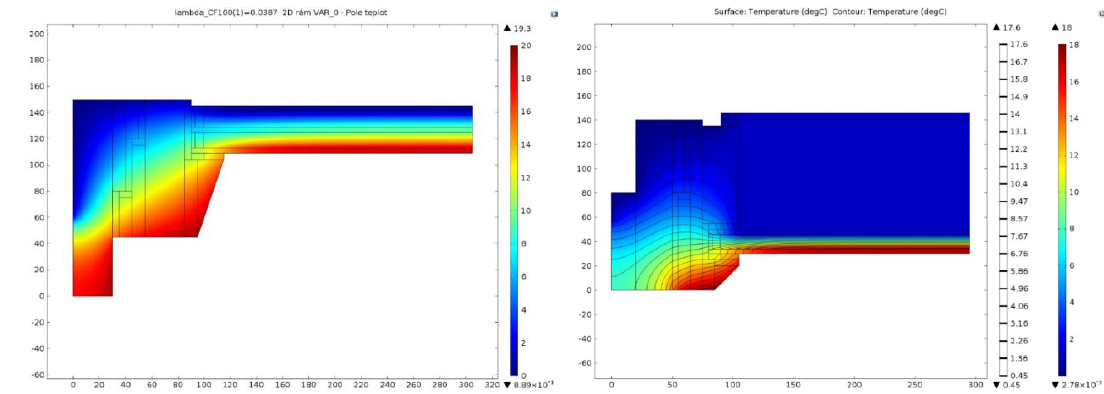
Figure 10. Temperature distribution for window configuration A ( left ) and B ( right ).